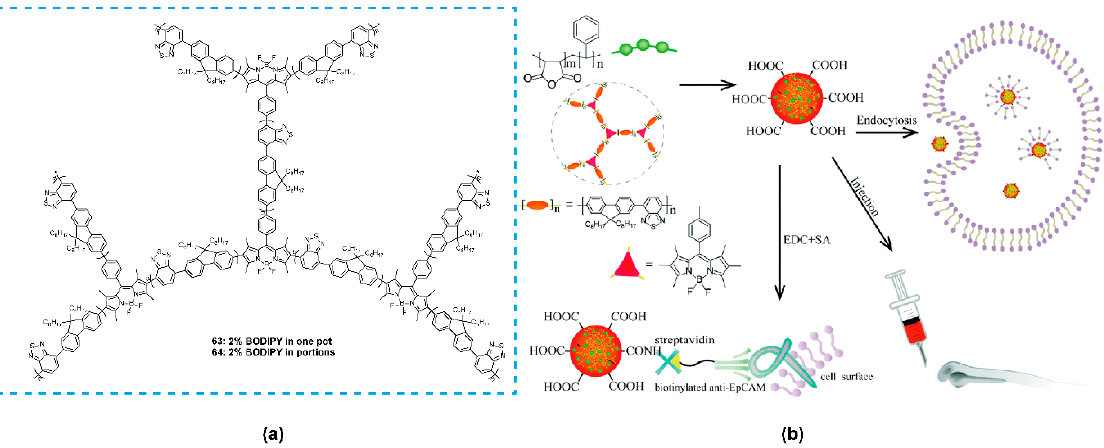
Figure 21. ( a ) Chemical structures of polymers 63 and 64 . ( b ) Illustration of the hyperbranched BODIPY-based Pdots and their bioconjugate probes for cellular imaging (Reproduced with permission from Reference [93]. Copyright @ 2017 Royal Society of Chemistry).